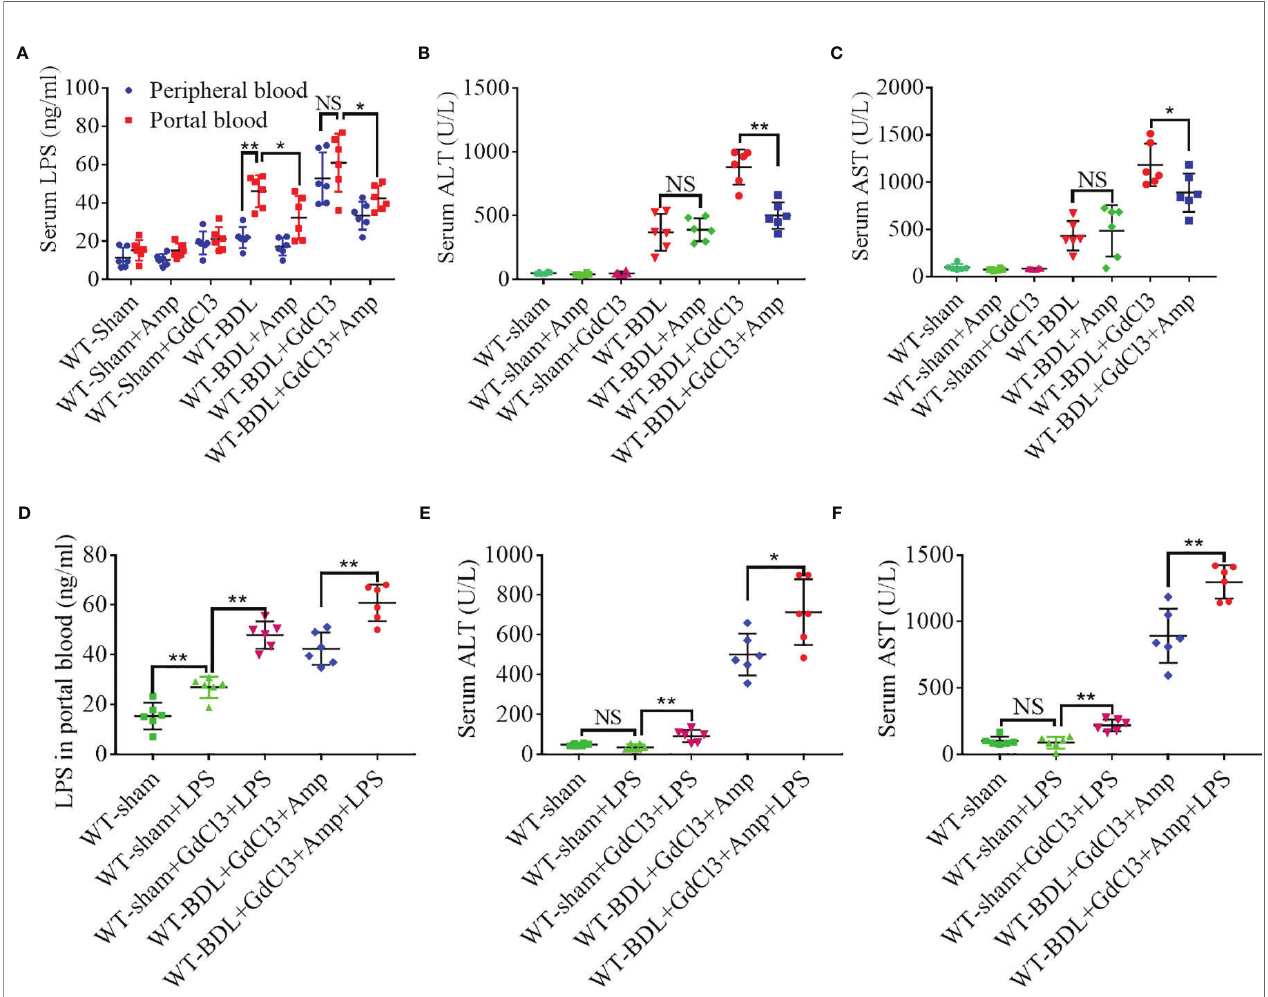
FIGURE 6 | Macrophage clearance of LPS from portal blood. Wild-type mice were subjected to BDL or sham operations and treated with GdCl3, ampicillin and/or LPS, as indicated. The mice were sacri fi ced 3 days later and portal blood and peripheral blood samples were collected separately. (A) Concentrations of LPS in portal and peripheral blood. (B, C) Effects of ampicillin and GdCl3 on liver function. (D) Effects of exogenous LPS injection on LPS concentration in portal blood. (E, F) Effects of LPS injection on liver function (n = 6 per group). Results are expressed as mean ± SD. *p < 0.05, **p < 0.01; NS, not signi fi